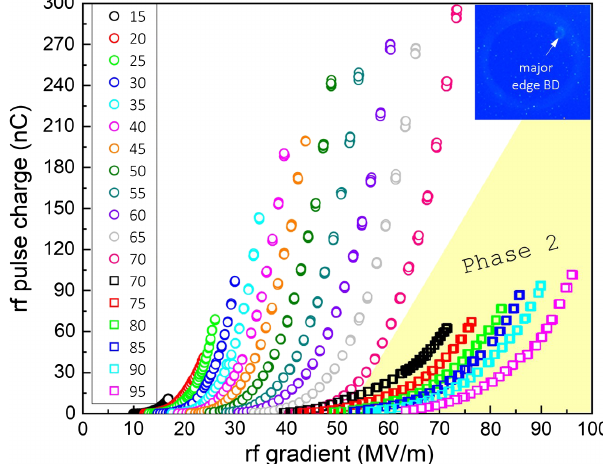
FIG. 4. The QvsE curves for Phases 1 and 2 separated into two regions corresponding to the experiment runs. In the legend, the numerical values label the maximum conditioning gradient achieved per QvsE curve (referred to as E h ). The inset shows an in situ taken image of the major breakdown event, located on the outer edge of the cathode puck at 1 o ’ clock (labeled with an arrow), that stopped the Phase 1